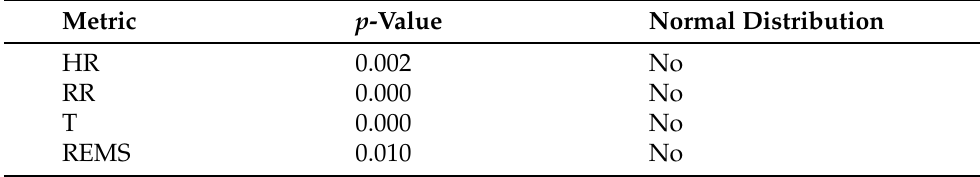
Table 6. Results of Kolmogorov–Smirnov test for metrics with the system.